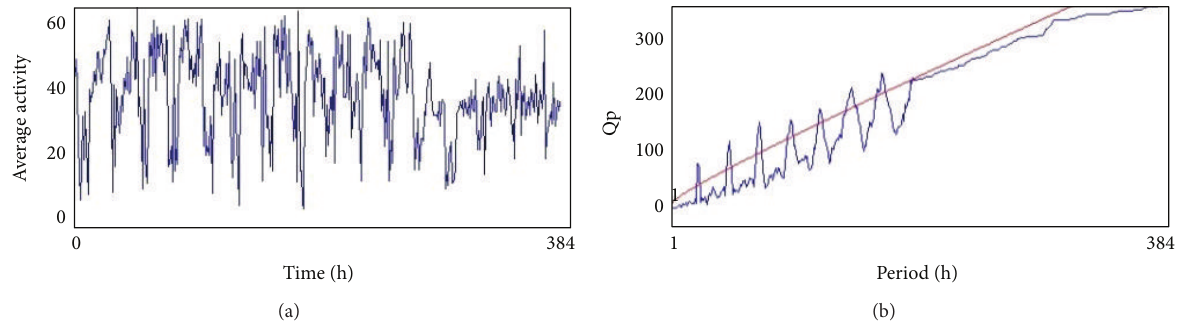
Figure 8: (a) and (b) show the average activity pattern and chi-square periodogram, respectively, for the PD flies exposed to 0.25 𝜇 L/mL of Centella asiatica leaf extract in diet ( 𝑁 = 20